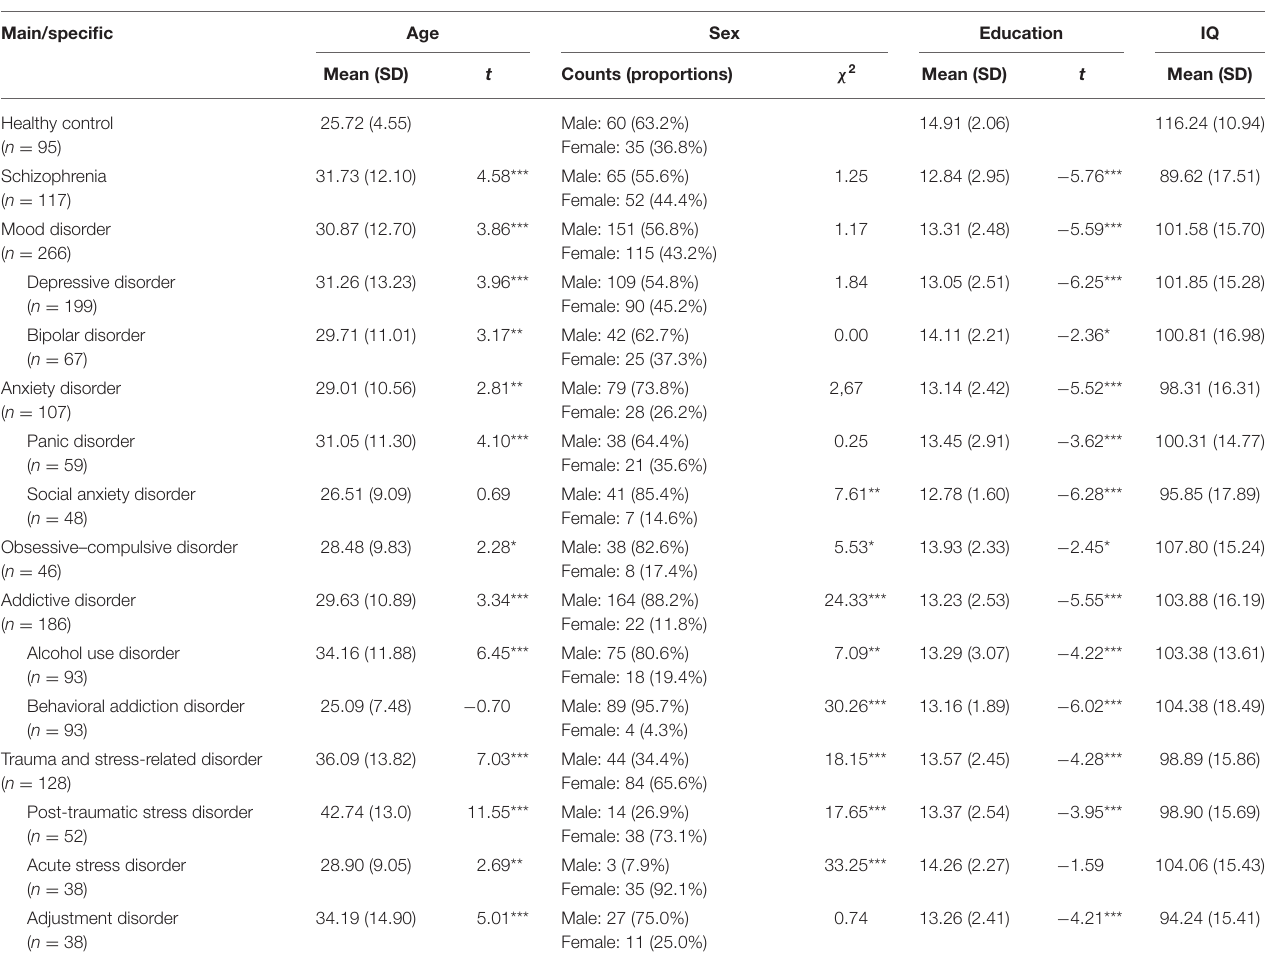
TABLE 1 | Demographic characteristics of samples.